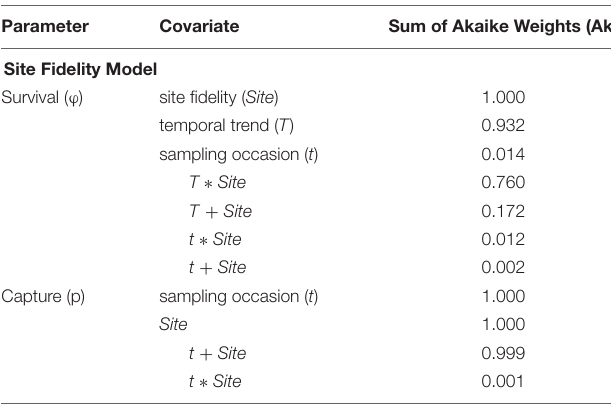
TABLE 4 | Summary of the covariates included in the Site Fidelity candidate models, sorted by their respective sum of Akaike weights (Ak) which reflect their relative importance across all candidate